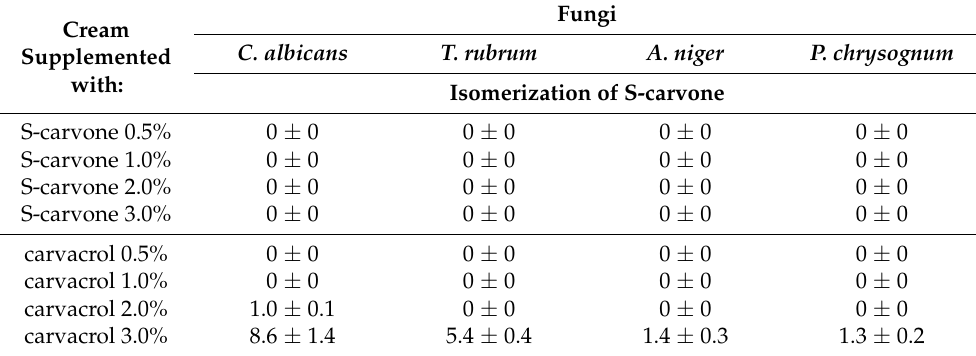
Table 3. Antifungal tests of creams containing S-carvone and geraniol, and its isomerization products.